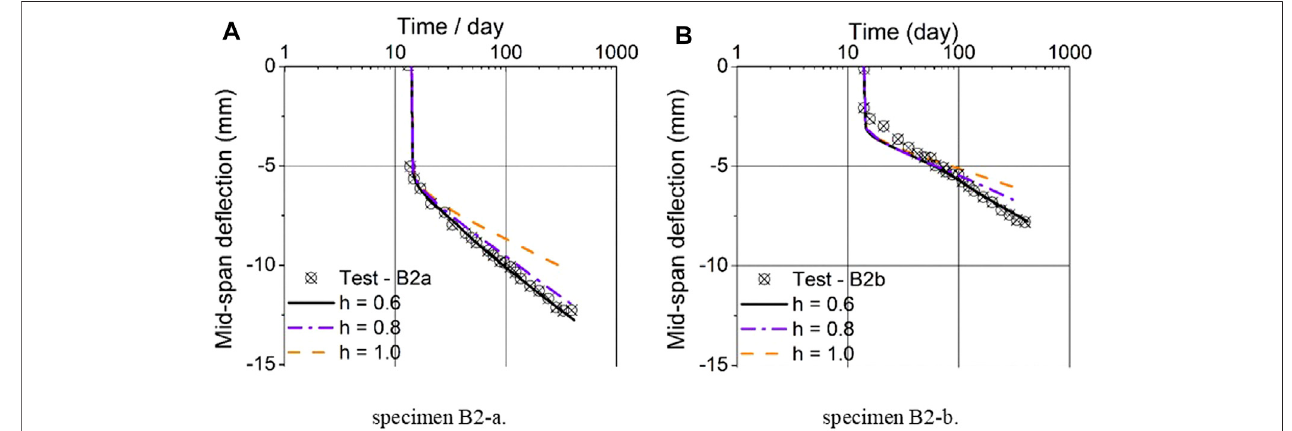
FIGURE 12 | Mid-span de fl ection curves at various